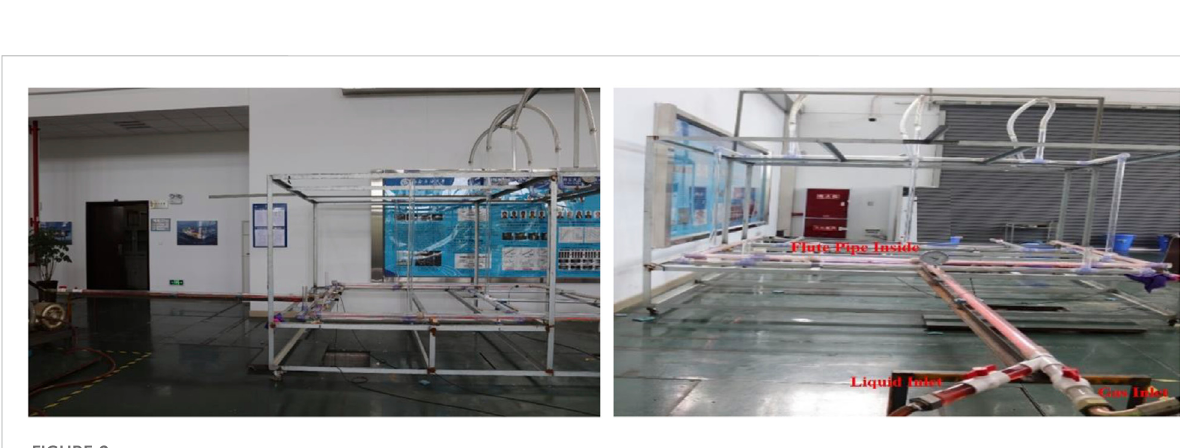
FIGURE 2 Experimental setup of fl ow maldistribution test.